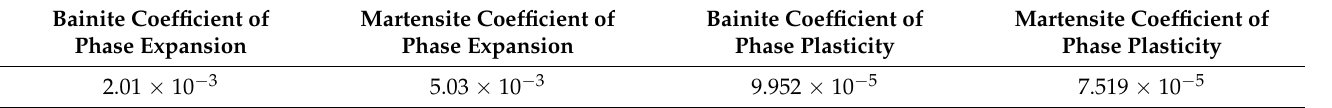
Table 4. GCr15 coefficient of phase expansion and coefficient of phase plasticity.